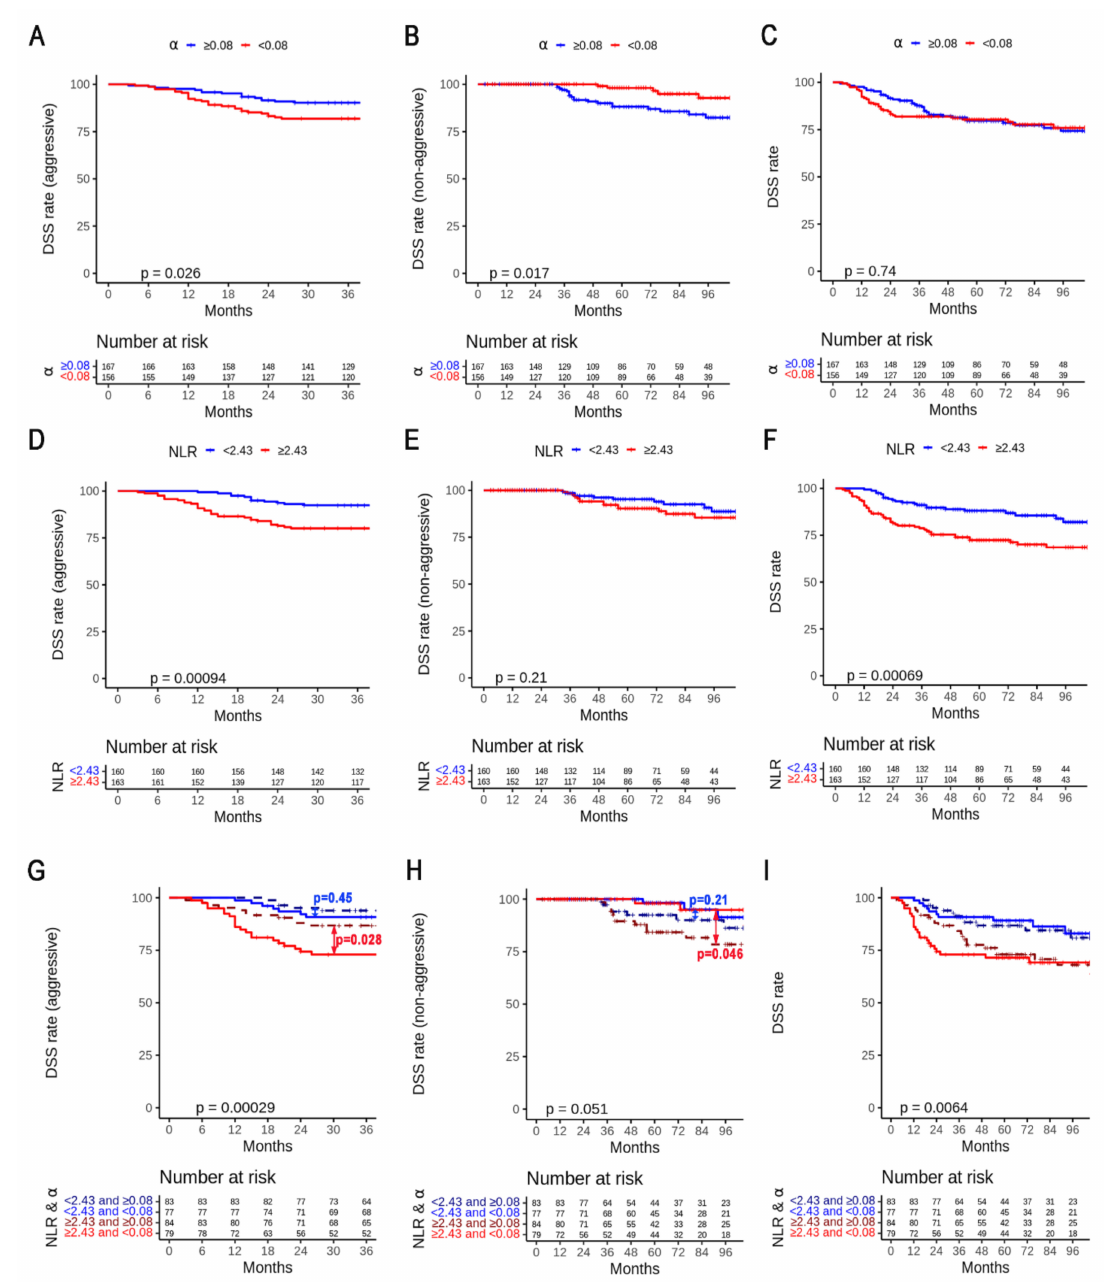
Figure 5. ( A , D , G ) Kaplan–Meier plots and log-rank tests of disease-specific survival (DSS) in the aggressive group, ( B , E , H ) DSS in the non-aggressive group, and ( C , F , I ) DSS according to median values of α , NLR, and both α and NLR, respectively. NLR—neutrophil-to-lymphocyte